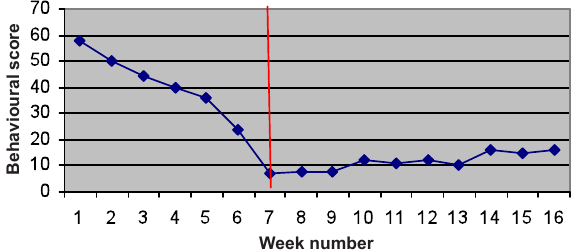
Figure 1. Behavioural scores of H . The weeks which 1 show the lowest score for H are between the 7 th and 9 th 1 weeks. In this case the antler was cast out during the 7 th week (vertical red line). The behavioural score was 42±11.73 during the hard antler phase whereas during the velvet phase it slipped to 9.66±2.25.